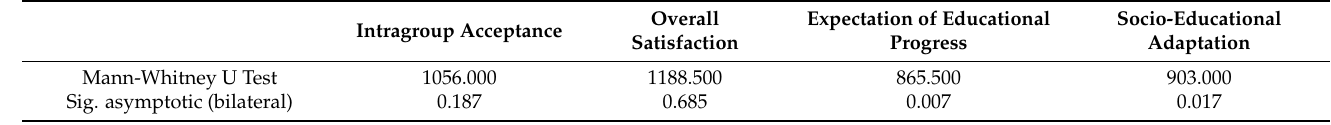
Table 6. Statistical data on first- and second-generation